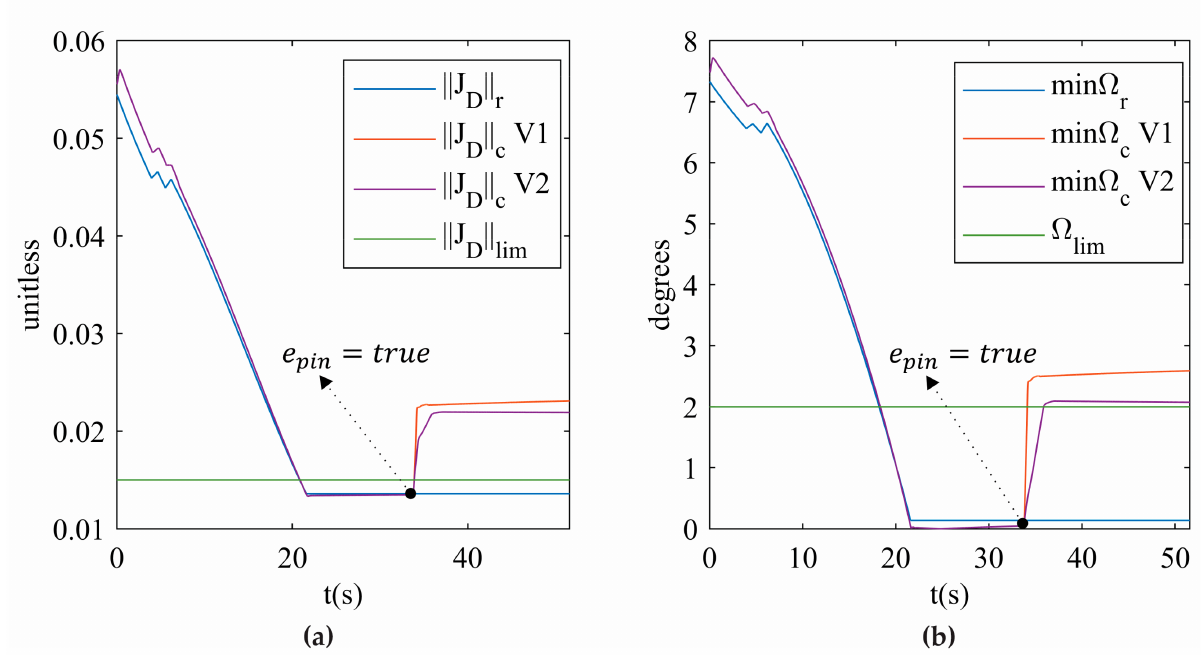
Figure 10. ( a ) (cid:107) J D (cid:107) ( b ) min Ω for trajectory 1 in the